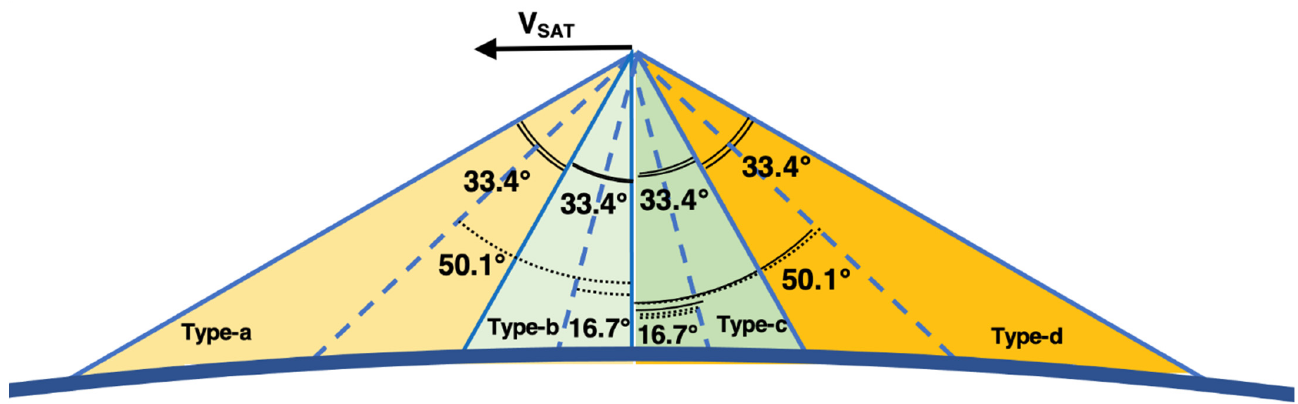
Figure 3. The HORUS camera quadruplet (Types a-b-c-d) FOVs and off-nadir boresight angles (not to scale). The relation between the on-board off-nadir boresight angle and the view angle at the observation point depends on the satellite orbital height, by straightforward geometrical considerations, indicated in Figure 4: sin η = R e / ( R e + h ) sin